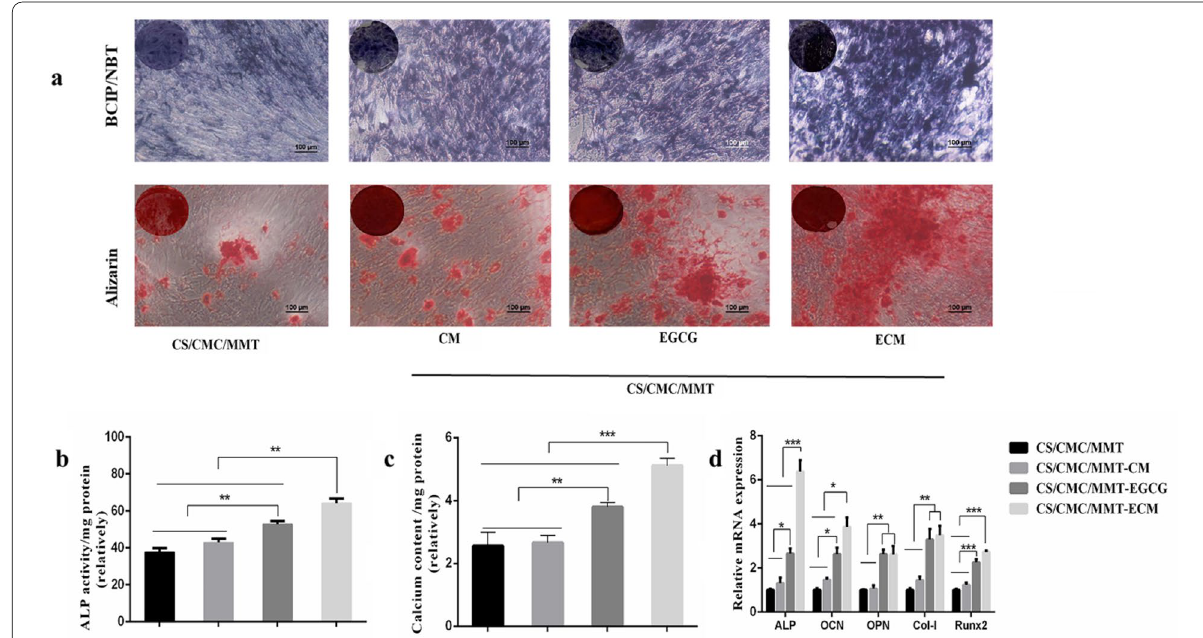
Fig. 9 a The HUMSCs were cultured for 7 days for ALP staining, and the HUMSCs were cultured for 14 days for Alizarin red staining (scale bar: 100 μM). b Quantitative analysis of ALP activity in HUMSCs cultured for 7 days. c Calcium contents in HUMSCs cultured for 14 days. d The quantitative evaluation of osteogenic‑related genes in